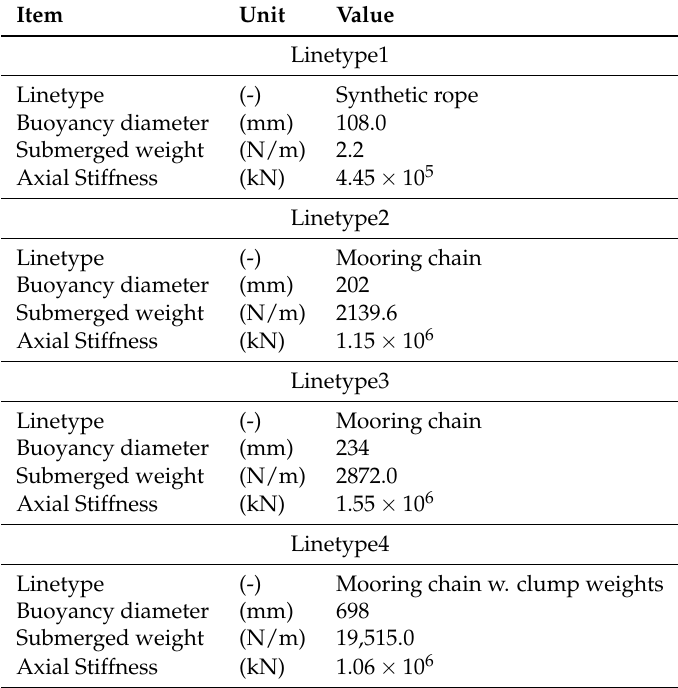
Table 9. Mechanical properties of the mooring system line